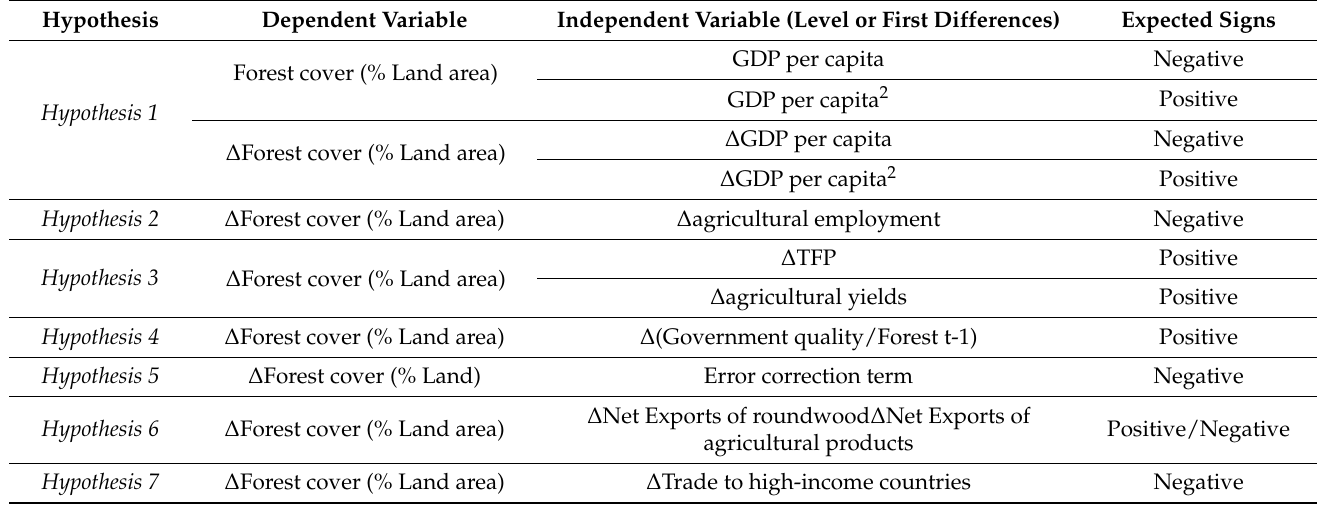
Figure 1. Theoretical causal framework. Note: Green, red, and grey arrows identify a positive, negative, or ambiguous effect from one variable to another, respectively. Dotted arrows are double headed, meaning a bidirectional effect between variables. Forest cover area represents the dependent variable of the model. Variables with an orange shape are those implemented in our long-run model while both orange and blue shape variables have been implemented in the short-run model. The λ 1...10 represent variables’ coefficients of our models. Table 1. Hypotheses